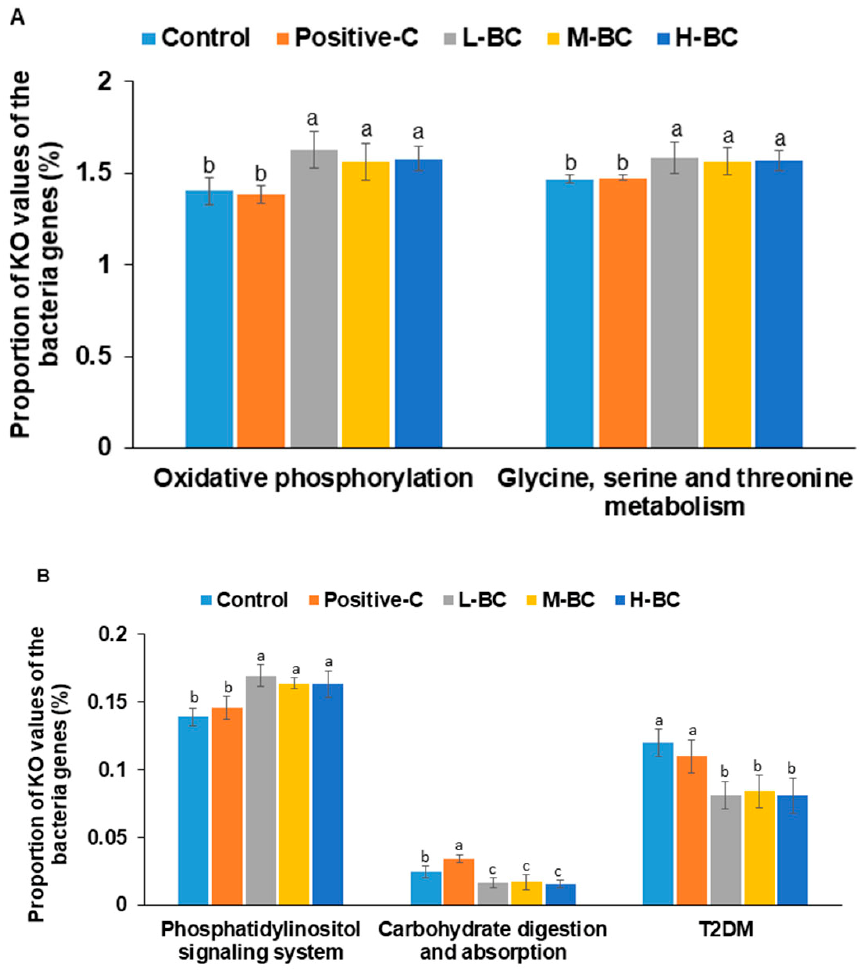
Figure 7. Prediction of gene function of the fecal bacteria by PICRUSt2. Partially pancreatectomized (Px) rats were fed a high-fat diet supplemented with 0% (control), 0.2% (L-BC; low dosage), 0.6% (M-BC; medium dosage), and 1.8% (H-BC; high dosage) blackcurrant extracts; 0.2% metformin (positive-C); plus 1.8%, 1.6%, 1.2%, 0%, and 1.6% indigestible dextrin for eight weeks. KO, Ky- oto Encyclopedia of Genes and Genomes Orthologues. The proportion of KO values of the fecal bacteria genes in ( A ) oxidative phosphorylation and glycine, serine, and threonine metabolism. ( B ) Phosphatidylinositol signaling system, carbohydrate digestion and absorption, and type 2 dia- betes (T2DM). Each bar represents the proportion of KO values of the designated metabolism in fecal bacteria genes of each group ( n = 10). a,b,c Different letters on bars indicate significant differences among the groups at p <